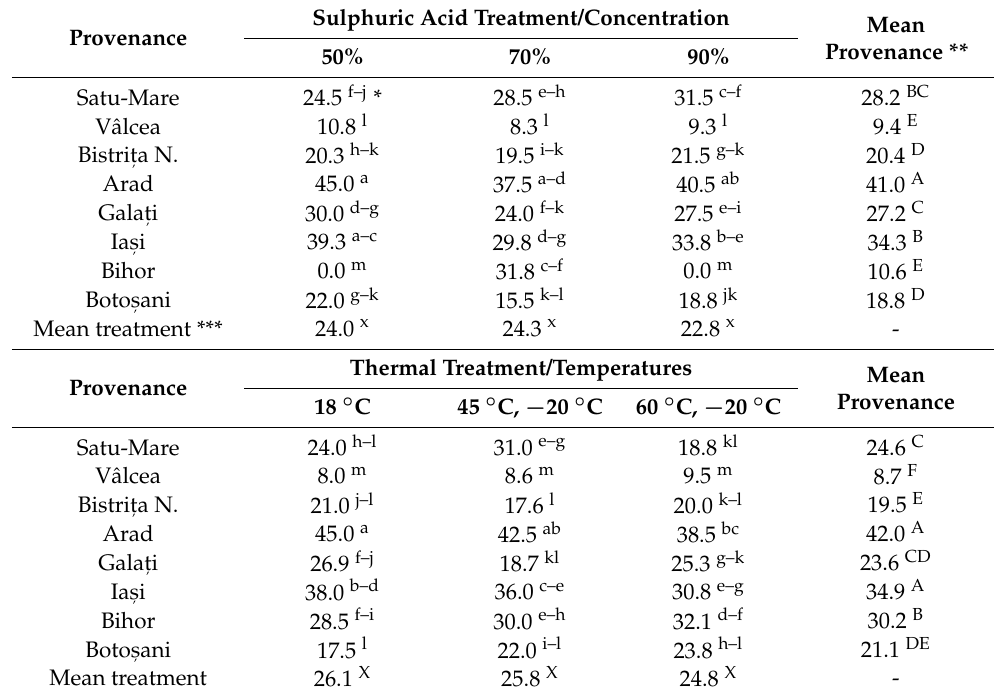
Table 4. Seedling’s height (cm) depending on the treatments applied to black locust seeds.